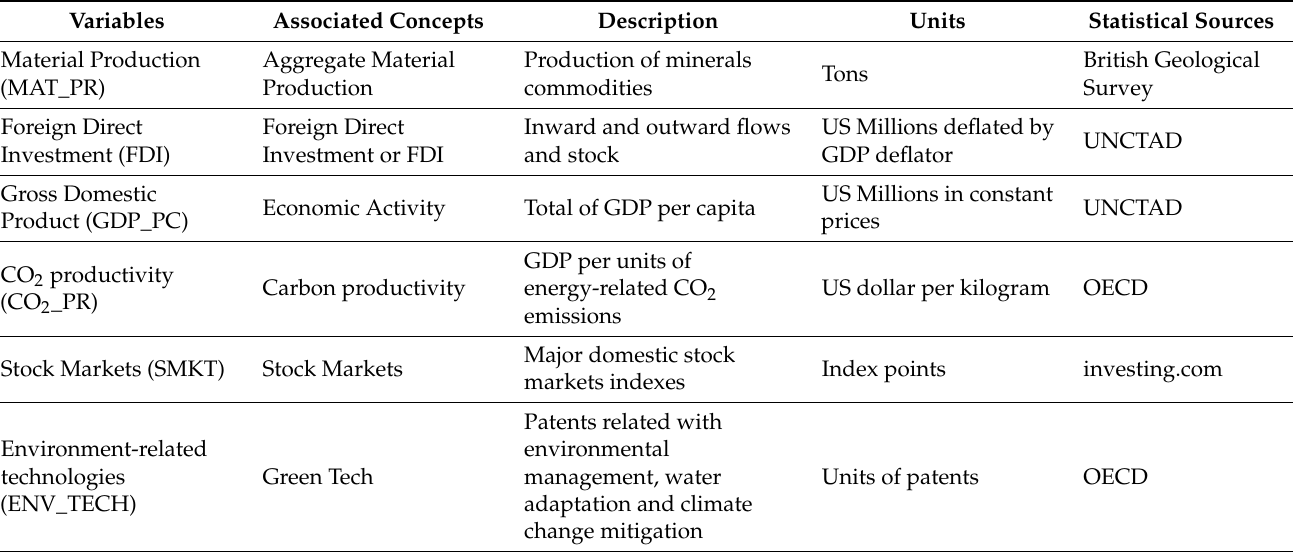
Table 1. Variables